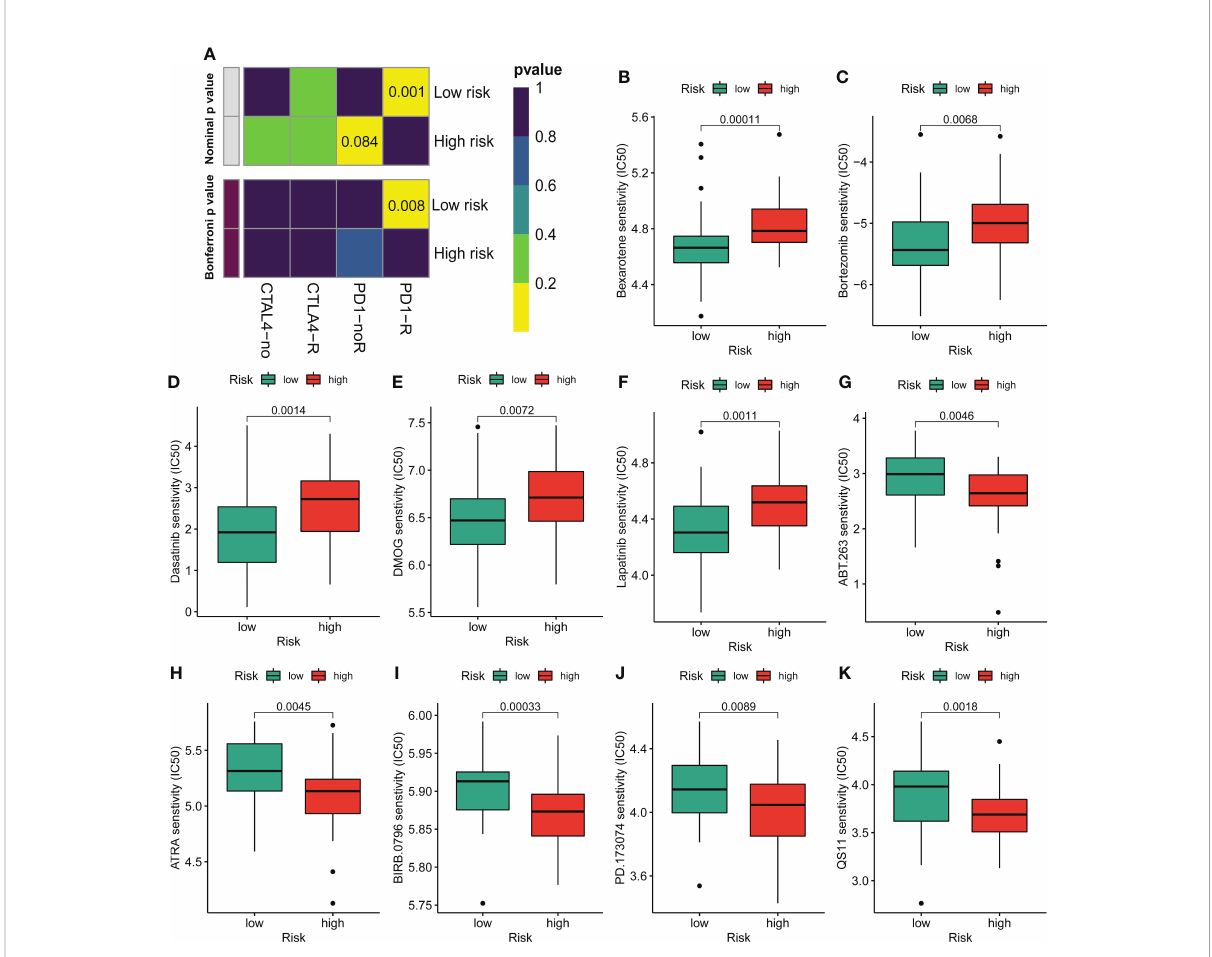
FIGURE 7 Assessment of immunotherapy and chemotherapy response ef fi cacy in patients from different risk groups. (A) Sensitivity prediction of distinct groups to the two immune checkpoint inhibitors in the OS cohort. No response, noR; response, R. (B – K) The sensitivity to chemotherapeutic drugs was represented by the half-maximal inhibitory concentration (IC50) of chemotherapeutic